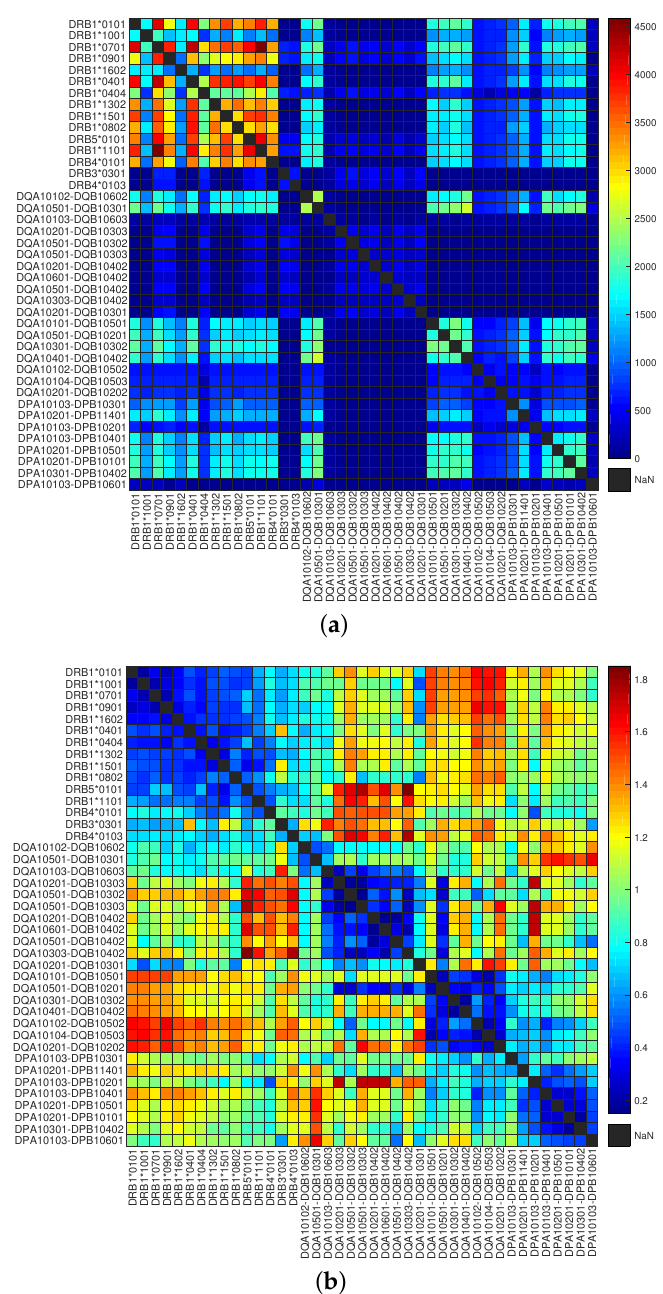
Figure 2. Comparison of the number of peptide binders with repertoire dissimilarity index (RDI) values of class II HLA molecules. ( a ) Heatmap of the number of peptide binders shared by HLA molecules; ( b ) heatmap of the RDI values between HLA